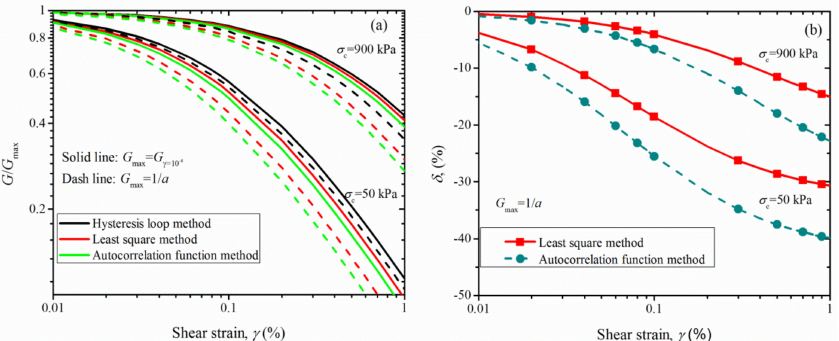
Figure 15. Comparison of ( a ) G / G max between 1/a and G γ =10 − 6 for three determination methods and ( b ) the corresponding percentage changes ( σ c = 50, 900